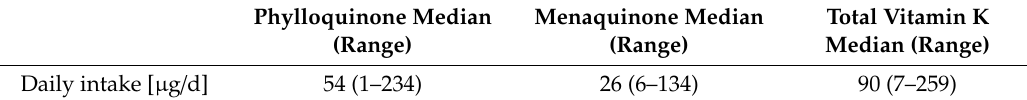
Table 2. Vitamin K intake in patients on haemodialysis based on a Food Frequency Questionnaire (FFQ).